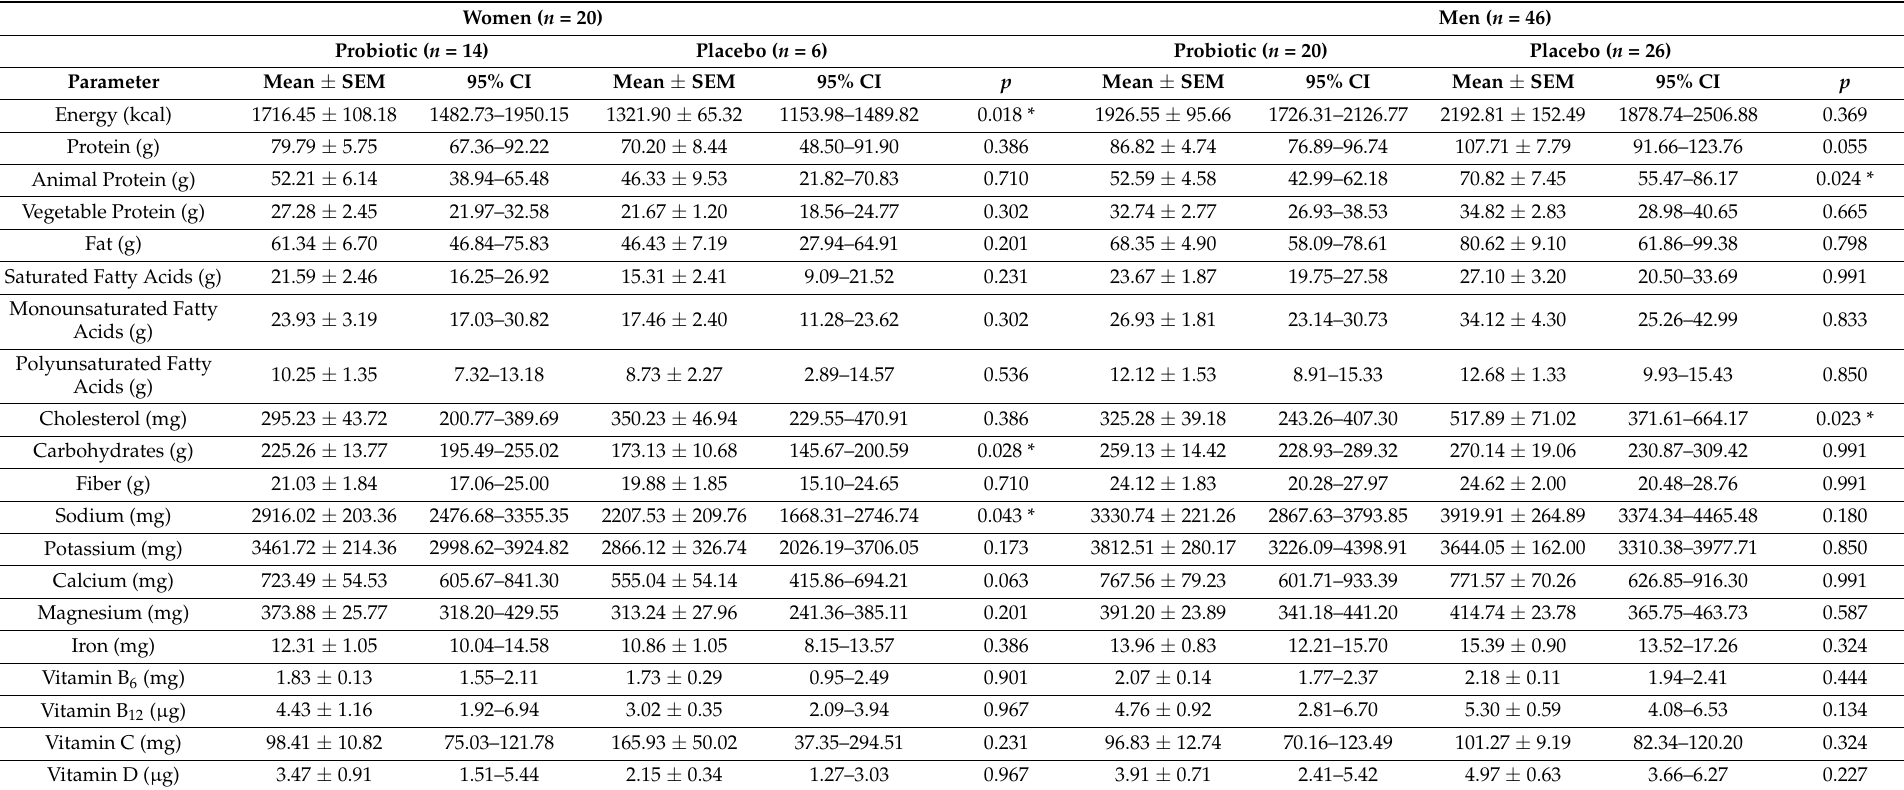
Table 3. Comparison of the diet of men and women from the probiotic and placebo groups. * Statistical significance ( p < 0.05) determined between the initial and final